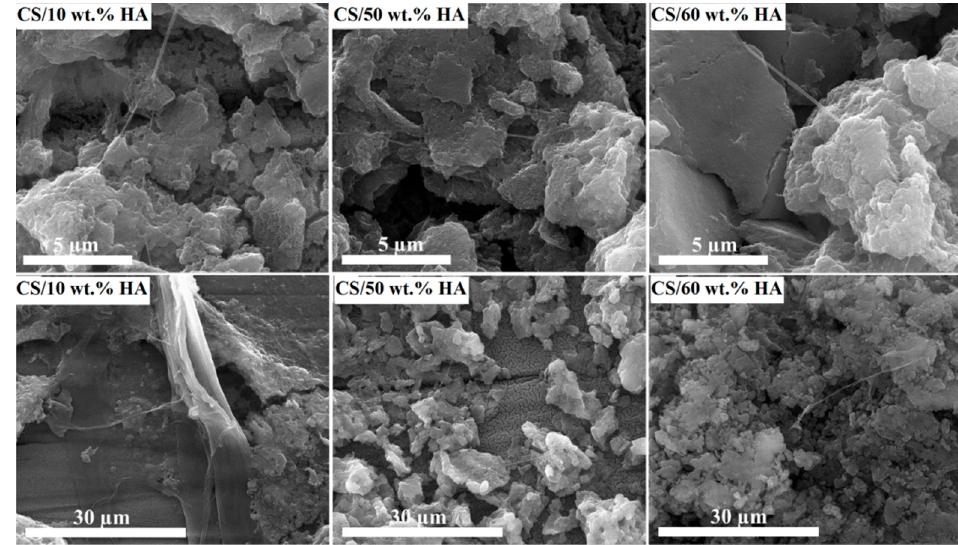
Figure 7. SEM micrographs of hMSCs on the CS/HA coatings at two different magnifications (5000× and 20,000×).